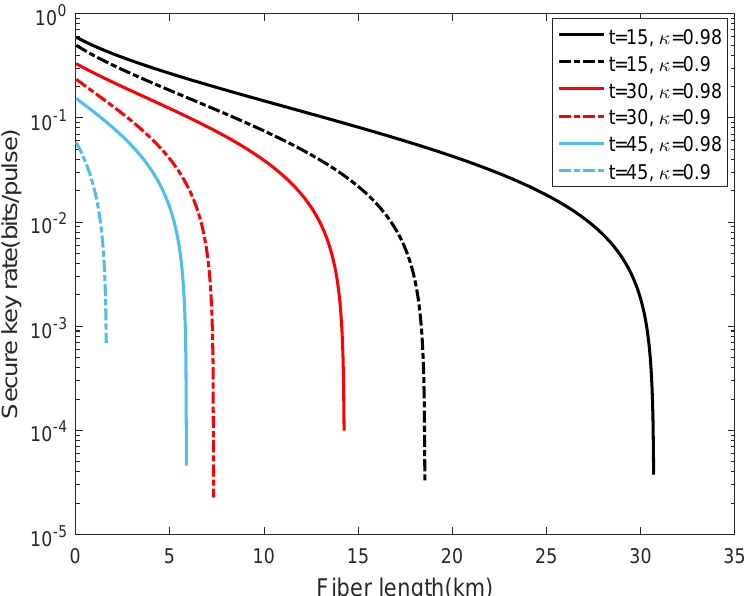
Figure 6. The secret rates of different numbers of legitimate participants and reconciliation efficiency for n = 50. The parameters are given by V A = 6, γ = 0.2 dB/km, ε = 0.005, η = 0.6, and v el = 0.01.